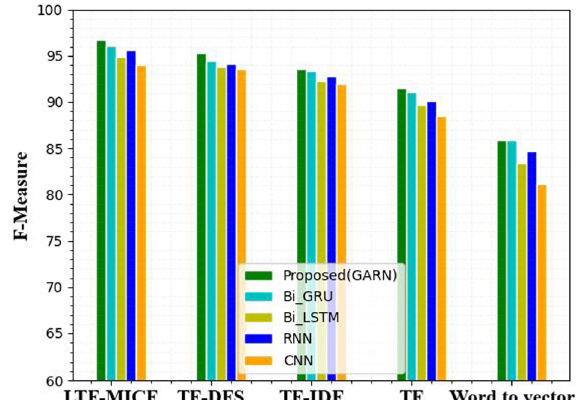
Fig. 6 F-measure of the classifiers with term weight schemes